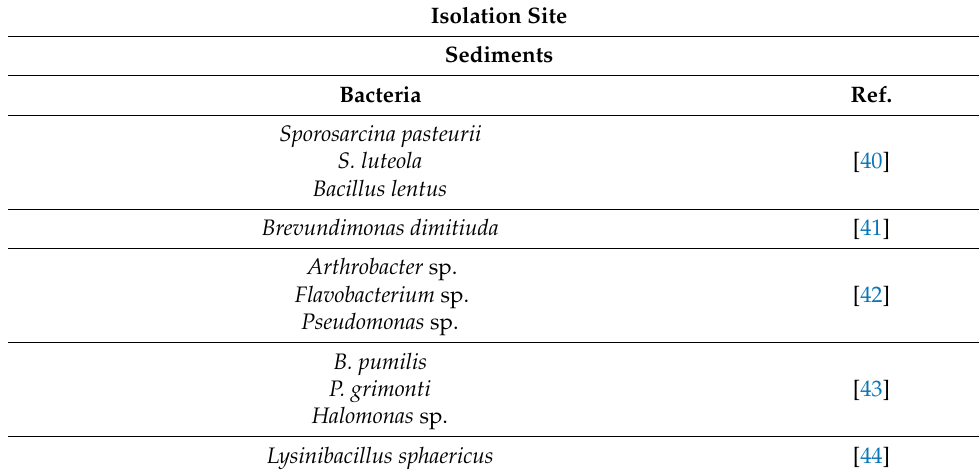
Table 1. An overview of certain bacteria with BICP potential isolated from cement-based